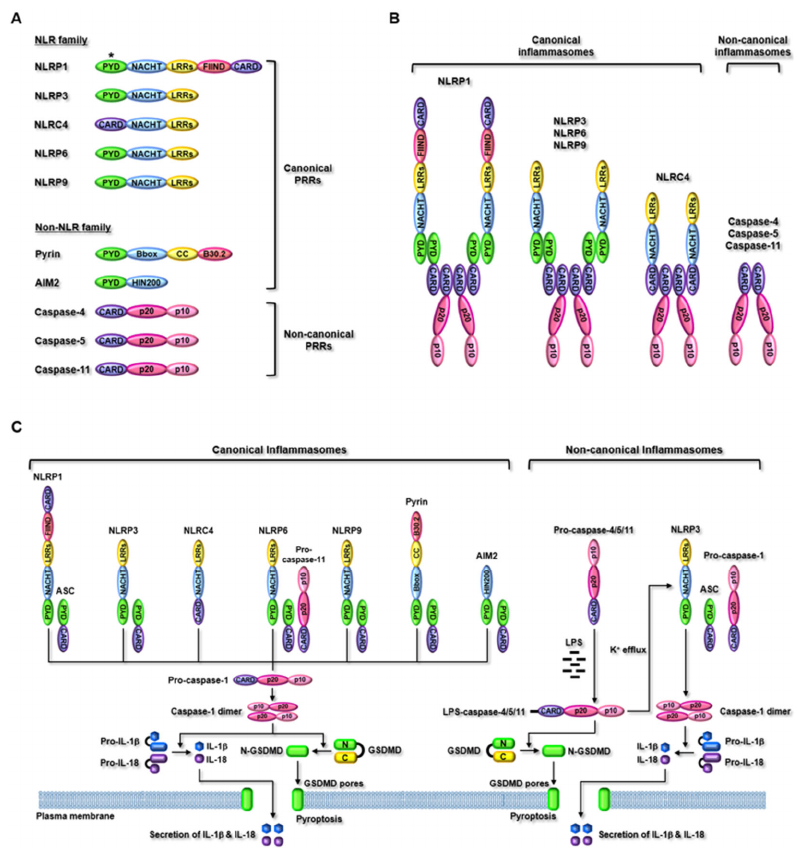
Figure 4. Inflammasome ‐ activated inflammatory signaling ( A ) the domain structure of PRRs. In ‐ flammasome PRRs are intracellular sensors that include PYD and/or CARD. The PRRs also include NACHT, LRRs, and FIIND in NLR family members. Pyrin includes Bbox, CC, and B30.2 and AIM2 includes HIN200. Caspase ‐ 4/5/11 have the same domain structure that includes CARD, p20,